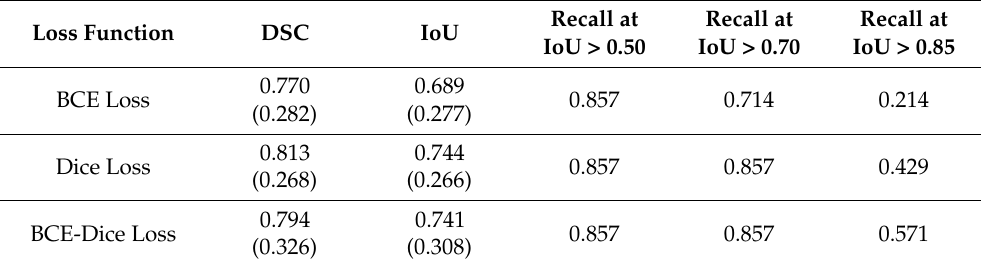
Figure 4. The performance of internal test on pancreatic cyst lesions segmentation. The dice similarity coefficient scores are shown in the bottom-right corners. Table 3. Performance comparison of the loss functions of the Attention U-Net for pancreatic cyst lesion segmentation on the internal test. The mean of performance is shown with the standard deviation in parentheses on the accuracy, specificity, sensitivity, dice similarity coefficient, and intersection over union. A recall score greater than the threshold is